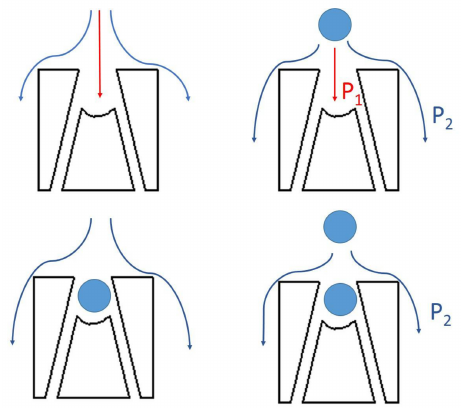
Figure 3. Schematic diagram of the cell capture process based on the hydrodynamic method. Table 1. The geometric parameters for the microfluidic microsphere-trap